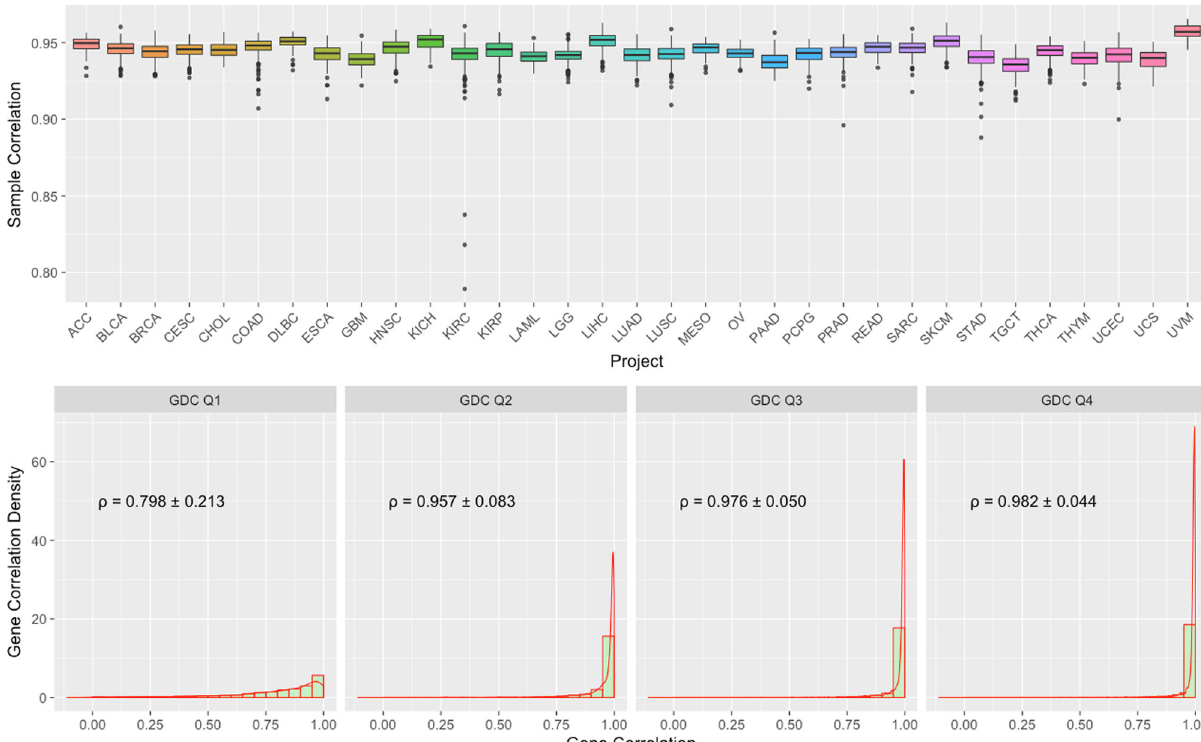
Fig. 4 Boxplots of Spearman correlation between GDC and TCGA mRNA expression. Top: Boxplots of Sample to Sample Correlation between GDC and TCGA by Project. n = 79/427/1202/309/45/328/48/171/170/546/89/603/321/145/525/423/573/550/86/265/182/186/548/105/265/472/404/ 156/564/121/199/56/80 biologically independent samples for projects ACC/BLCA/BRCA/CESC/CHOL/COAD/DLBC/ESCA/GBM/HNSC/KICH/KIRC/ KIRP/LAML/LGG/LIHC/LUAD/LUSC/MESO/OV/PAAD/PCPG/PRAD/READ/SARC/SKCM/STAD/TGCT/THCA/THYM/UCEC/UCS/UVM, respectively. Bottom: Combined Boxplots and Density Plots of Gene to Gene Correlation between GDC and TCGA. All genes are categorized by four GDC groups (Q1 – 4) based on their average expression values. Mean and standard deviation of gene to gene Spearman ’ s correlations are calculated by these four